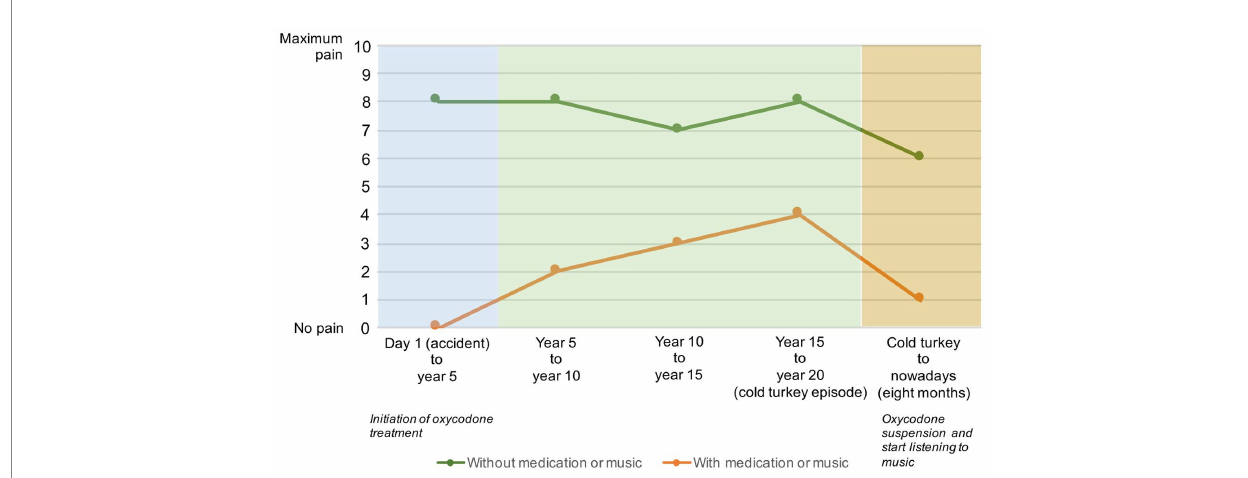
FIGURE 1 Pain intensity over 20 years from the accident to 8 months after the cold turkey episode: green line—intensity when the participant used medication (oxycodone from the 8th month after the accident to year 20 just before the cold turkey episode) or listened to music (at the end of year 20 to 8th month after at the moment of the assessment). Orange line—intensity when the participant did not use medication (before the oxycodone treatment and some rarely days when she suspended the treatment for a long 20 years) or did not listen to music to relieve the pain. At first, 8 months before the first dose of oxycodone, she felt an intensity of 8 and then fluctuated to 7 when she began to be more active, riding a bike, and having a natural path by eating anti-inflammatory foods and avoiding sugar and salt. When she started using the medication, she felt no pain at first, but it increased right before the cold turkey episode. Since she listens to music, she has had periods completely free of pain, sometimes 1 or 2 days without pain, but with an intensity 6 if she does not listen to music: “ if you ask me where my pain average was in the last 2 months I would say maybe a 3 in the worst period… Once in a while, if I go hiking up high elevations may be 6 or 7. But every day at my desk call week is 4 maybe.